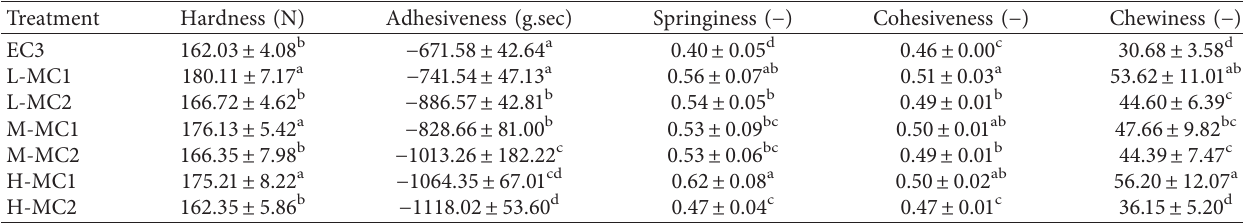
Table 2: Texture profiles of cooked rice from conventional cooking and microwave cooking.